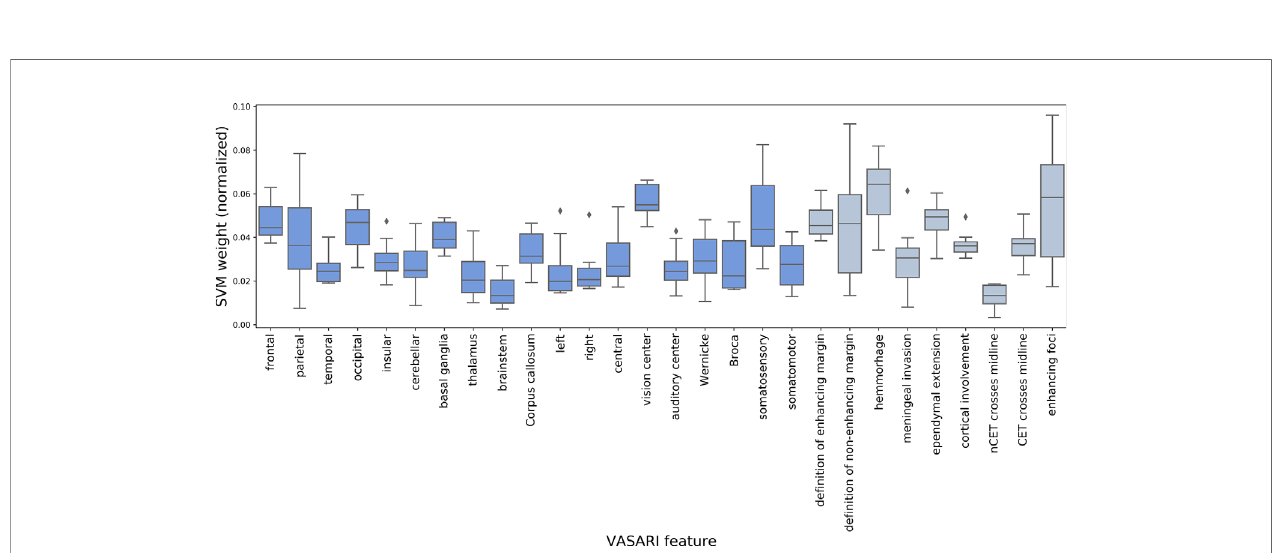
FIGURE 9 | Result for repeated fi tting of linear soft-margin Support Vector Machine (SVM) for a total of 12 different hyperparameter con fi gurations. Higher median SVM weights across different hyperparameter con fi gurations indicate VASARI feature which are more important for differentiation of histological BM subtypes (4 classes) (dark blue = localization-based features, gray = appearance-based